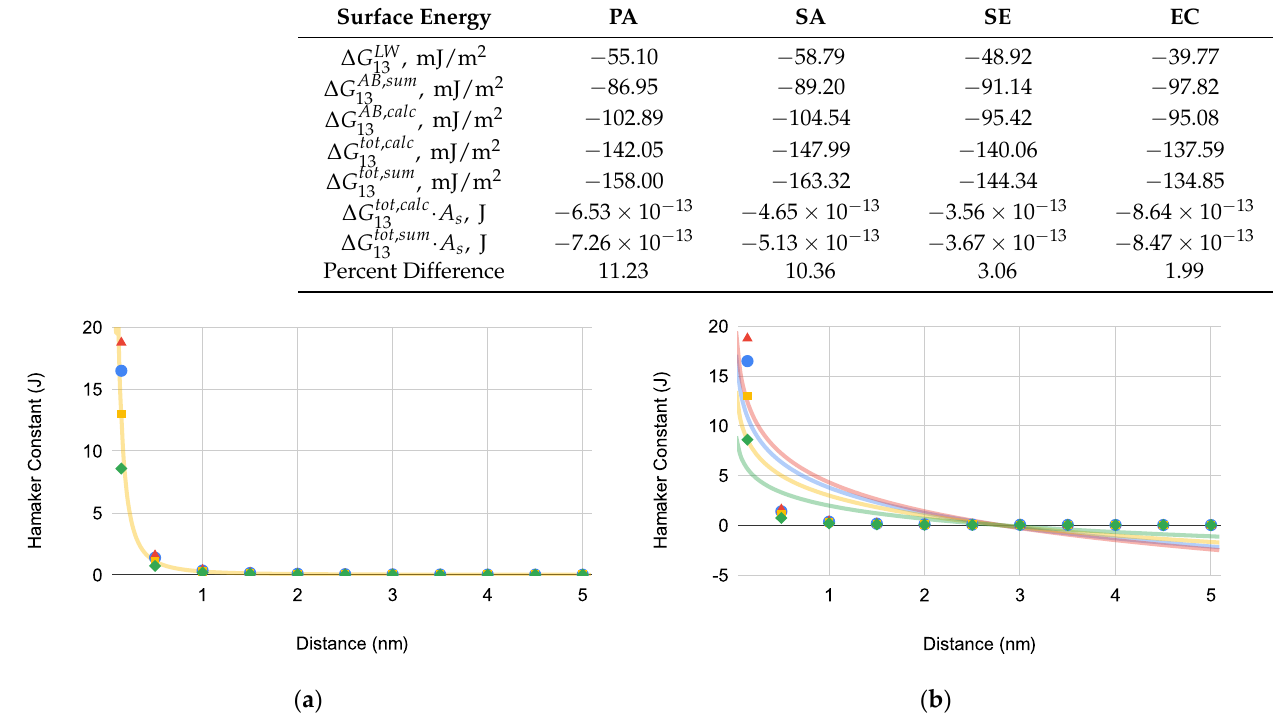
Table 2. Numerical experimental surface energy results for bacteria (PA, SA, SE, and EC) with superhydrophilic substrates where the subscripted 13 indicates bacteria dispersed in water interacting with a superhydrophilic substrate with surface energies equivalent to water.